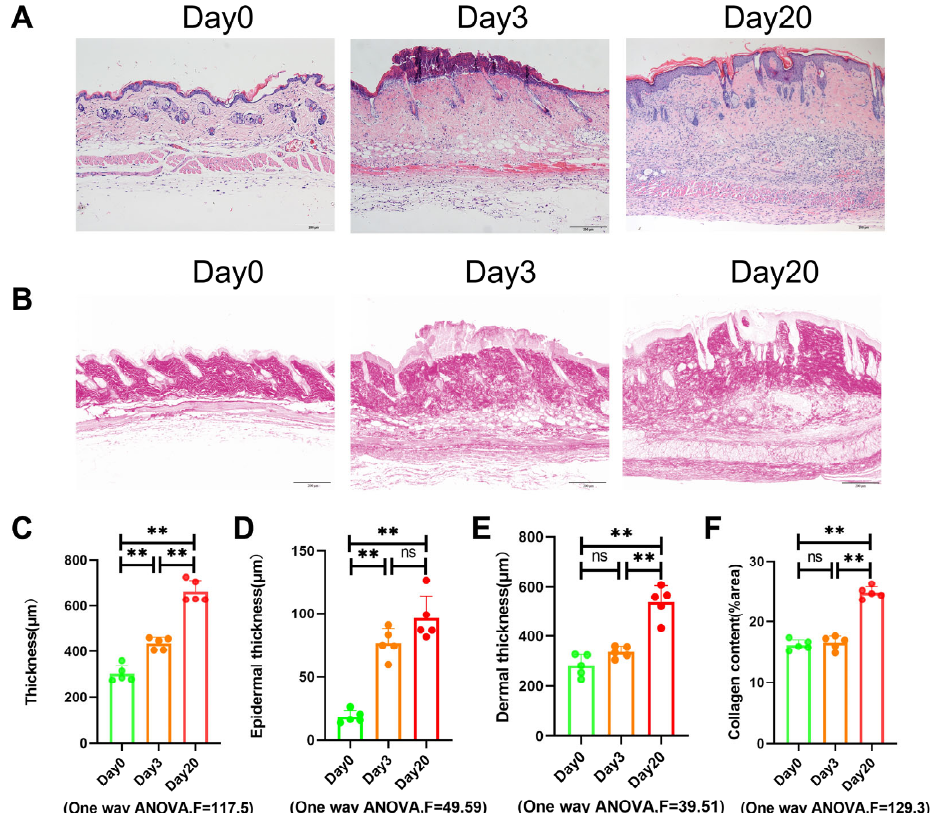
Figure 2. LL-37-induced rosacea-like lesions presented with epidermal thickening without collagen density changes in the early stage and dermal thickening with increased collagen density in the late stage. ( A , C – E ) Hematoxylin-eosin (H&E) staining of lesioned skin (scale bar = 200 µm). ( B , F ) Representative skin sections stained with Van Gieson staining (VG staining) (scale bar = 200 µm). Data are presented as the mean ± SD; n = 5 for each group. ** p < 0.01.